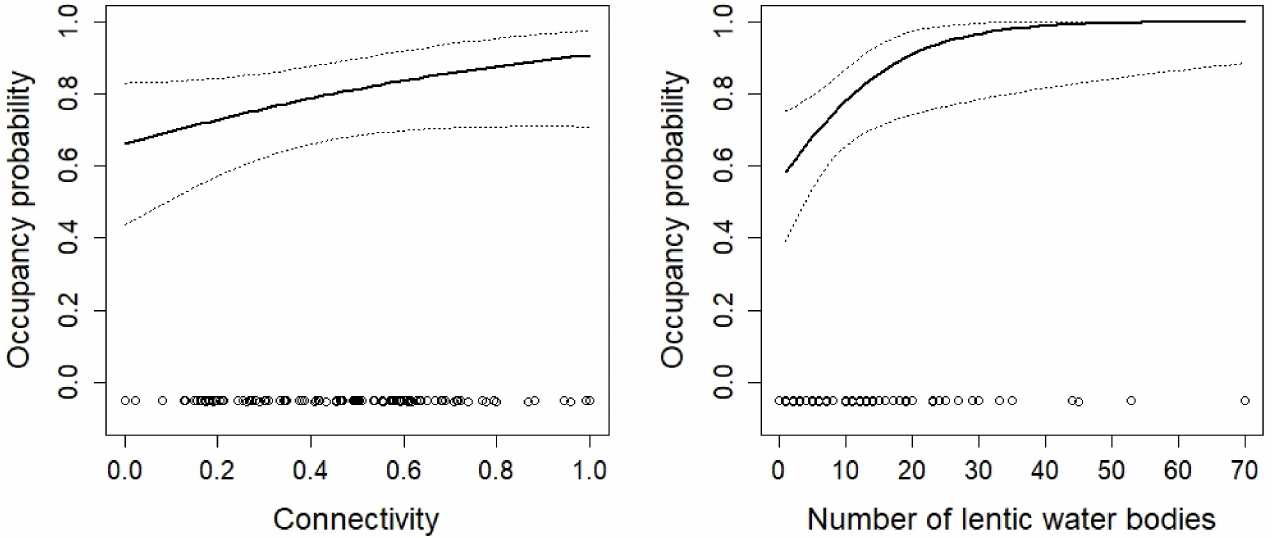
Figure 8. The effect of connectivity and the number of lentic water bodies on the occupancy probabil- ity of Pelophylax frogs. For additional explanations, see the caption of Figure